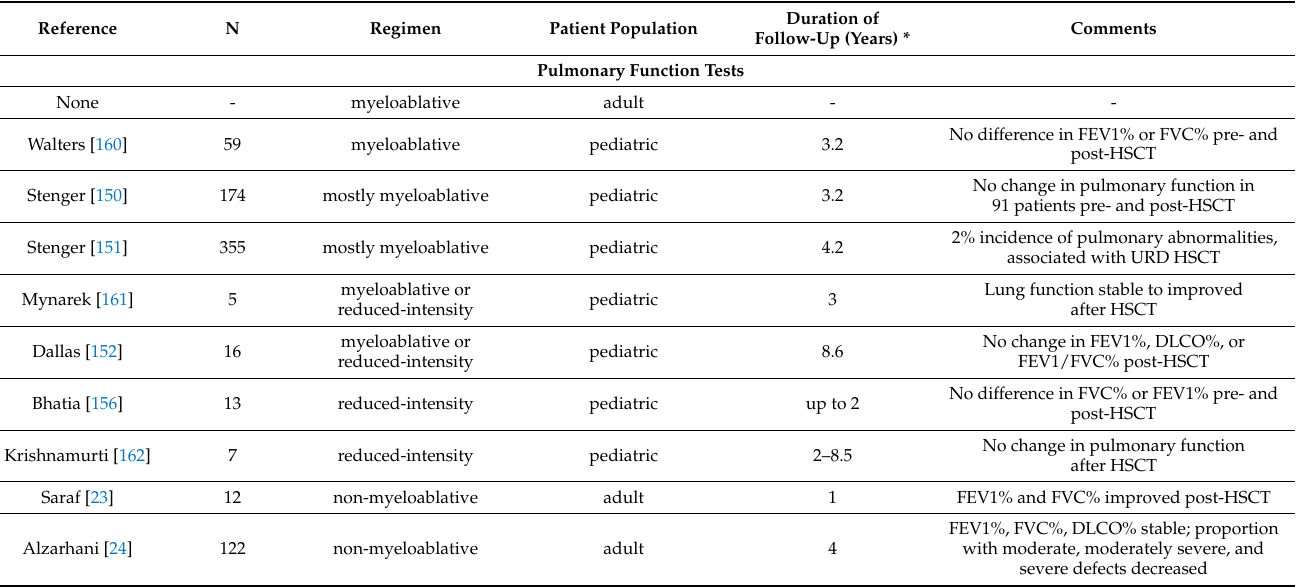
Table 3. Late effects studies assessing pulmonary function in patients with SCD who undergo